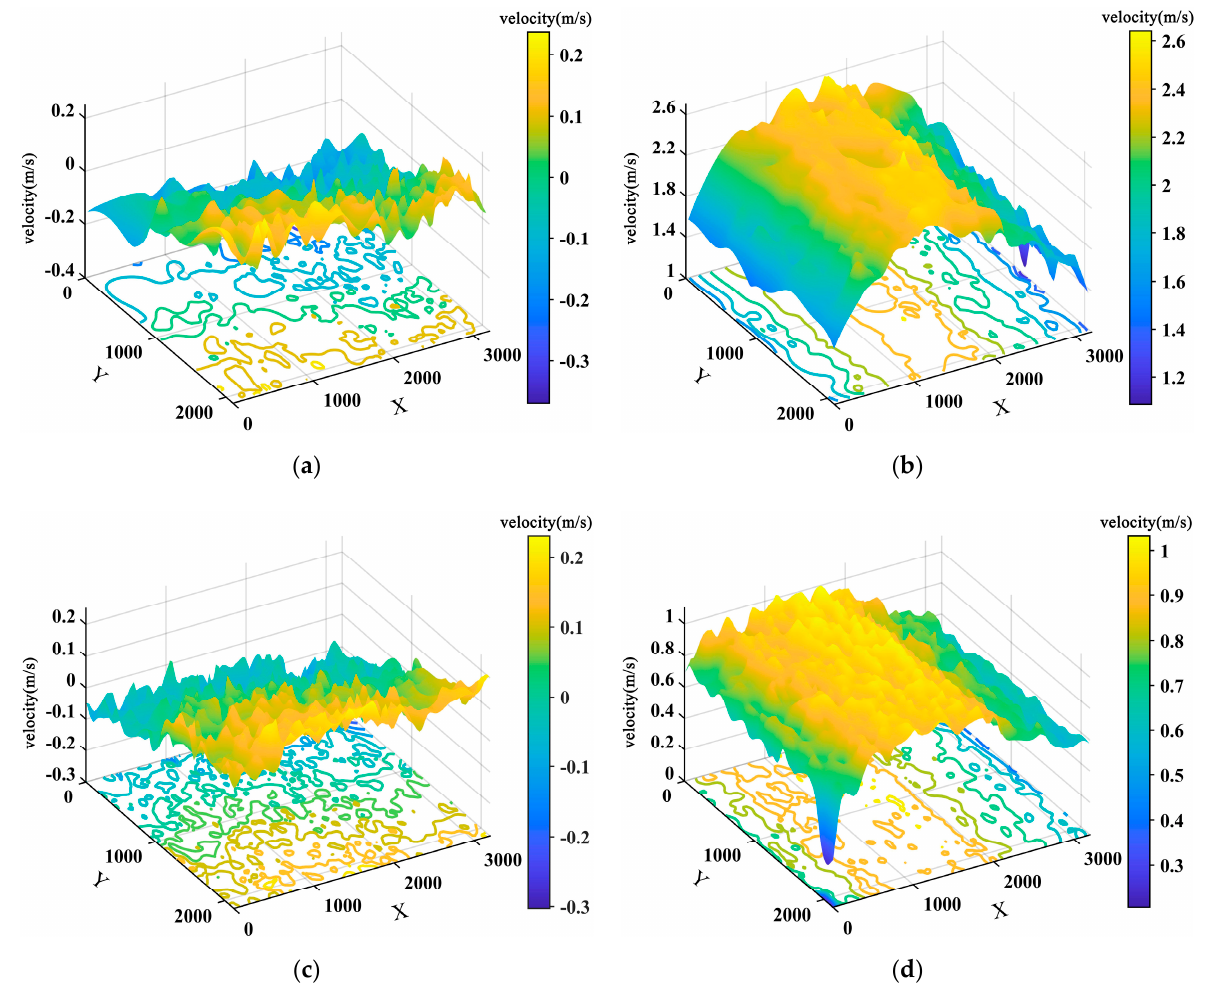
Figure 9. Distribution law of ice velocity components: ( a ) the transverse components of the ice velocity at 16:00 on 25 April 2021; ( b ) the longitudinal components of the ice velocity at 16:00 on 25 April 2021; ( c ) the transverse components of the ice velocity at 8:00 on 26 April 2021; ( d ) the longitudinal components of the ice velocity at 8:00 on 26 April 2021.